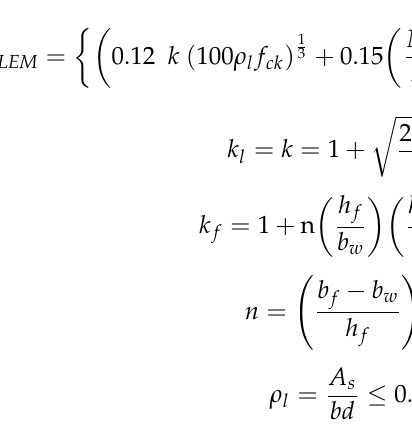
Table 5. Comparison of experimental results with RILEM and fib-MC2010